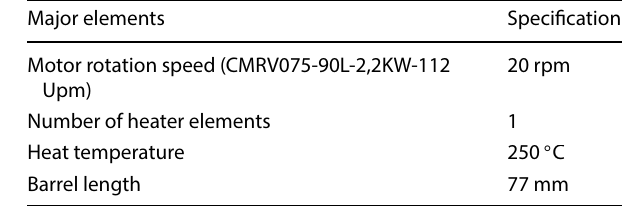
Table 8 Extruder test with a single